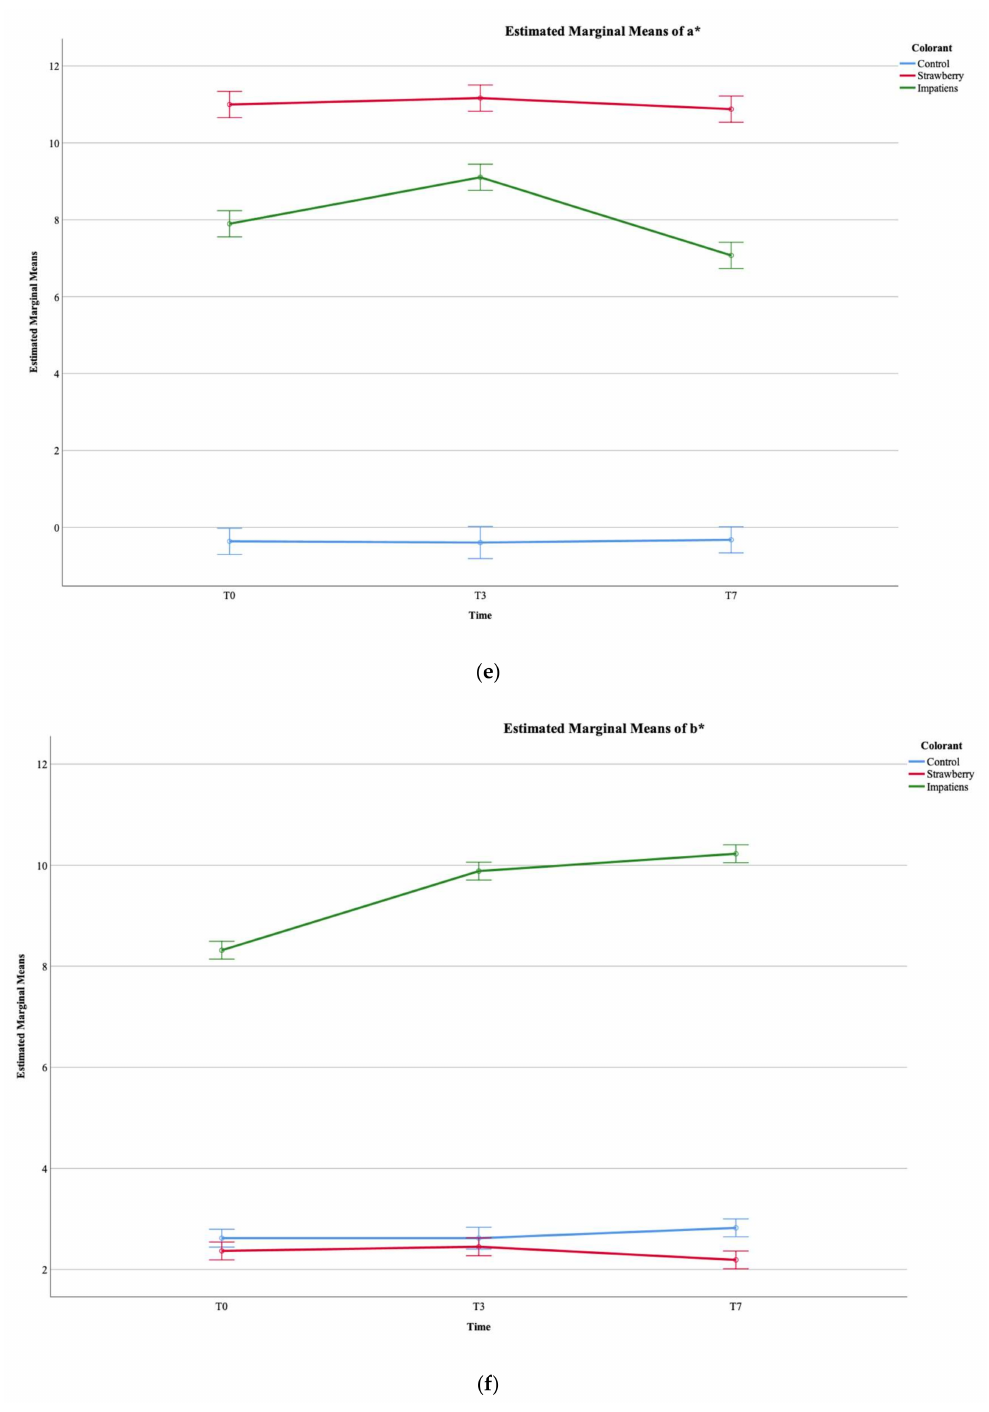
Figure 2. Estimated Marginal Means plots for ( a ) proteins, ( b ) carbohydrates; ( c ) fructose; ( d ) L *; ( e ) a *, and ( f ) b